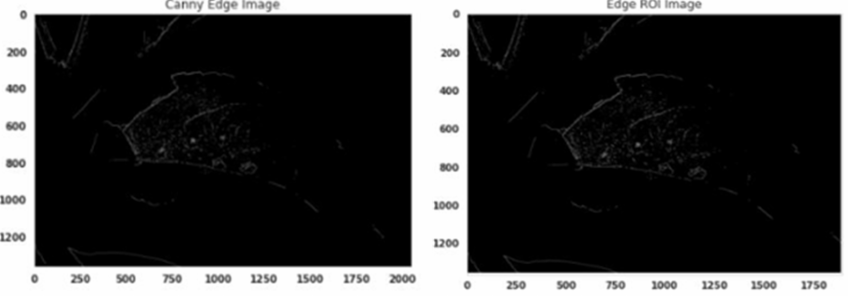
Figure 6. Canny Edge Image, Edge ROI